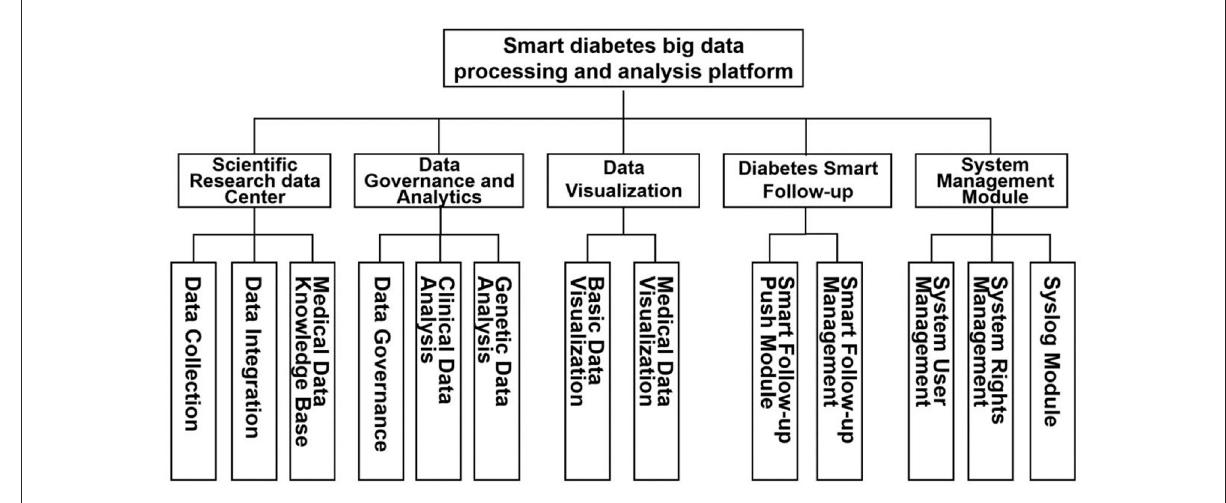
FIGURE3 Functional block diagram of RDDP system.